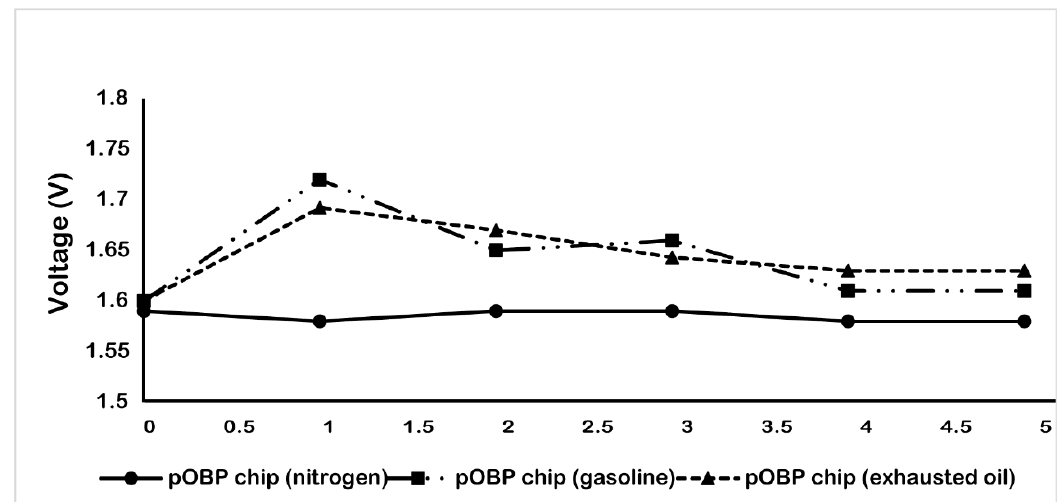
Figure 7. Variation of the voltage, during the time (5 h) in the absence (nitrogen) and in the presence of gasoline and exhausted oil vapor. The measurements were acquired in gas, at room temperature by using the 75 µm sensor chip configuration.